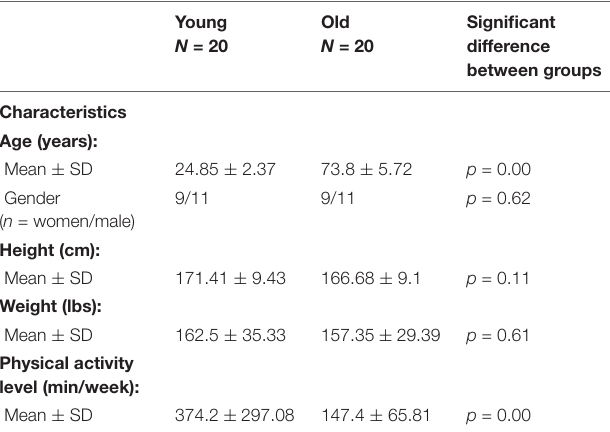
TABLE 1 | Participant’s